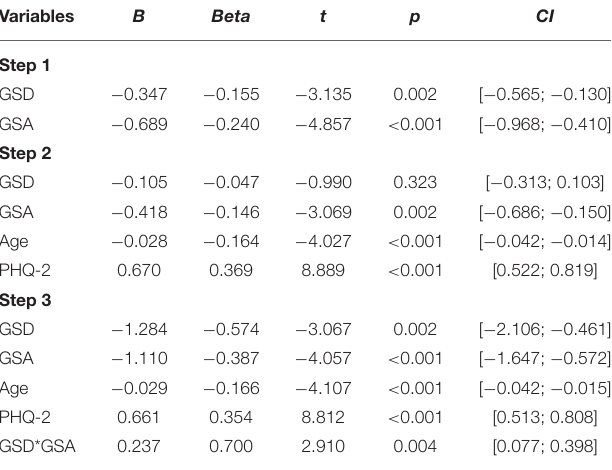
TABLE 3 | Hierarchical regression analysis with SBQ-R as dependent